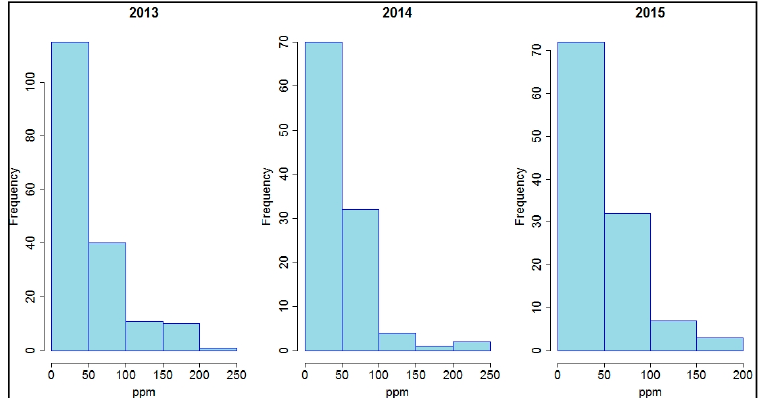
Figure 3. Frequency distributions of soil Fe for every year.